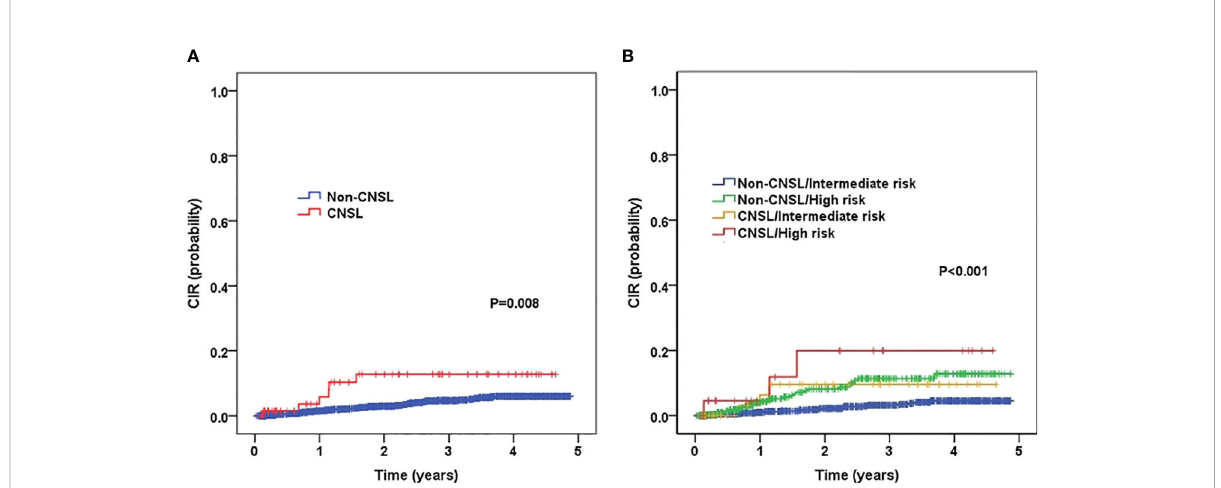
FIGURE 2 Probability of CIR (cumulative incidence rates) for childhood B-cell ALL patients according to central nervous system (CNS) status, and according to the combined CNS status and risk strati fi cation. (A) Probability of CIR for patients with CNSL and non-CNSL at diagnosis. (B) Probability of CIR for patients according to the combined CNS status and risk strati fi cation.